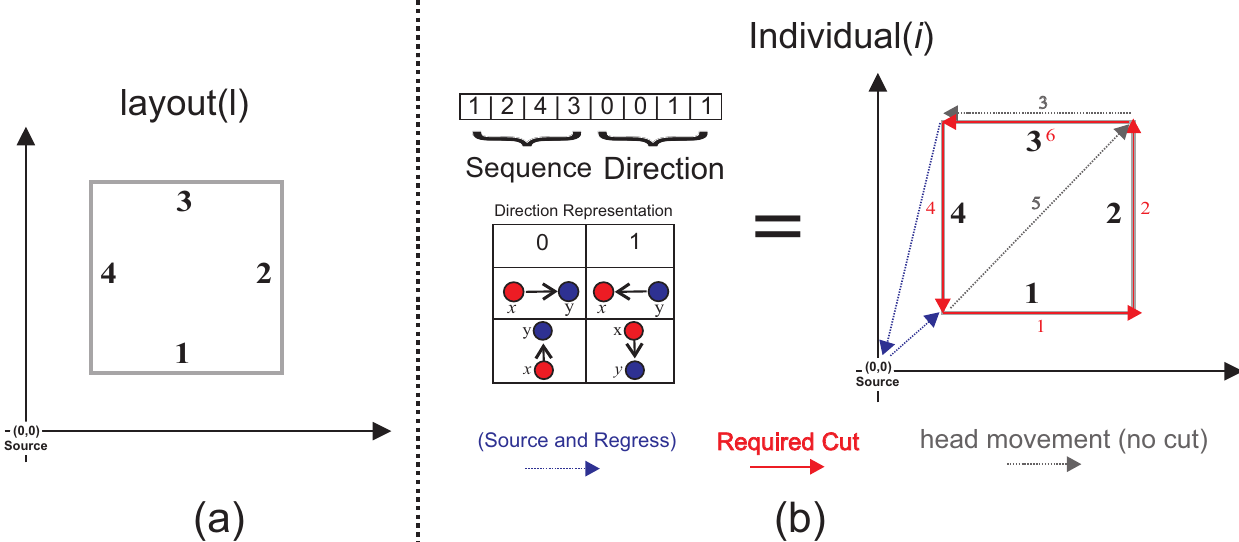
Figure 6. Example of an individual representation for input layout. ( a ) illustrates an input layout. ( b ) the coding process for each individual describes that the input layout has four edges and, therefore, the individuals’ representation vector contains eight